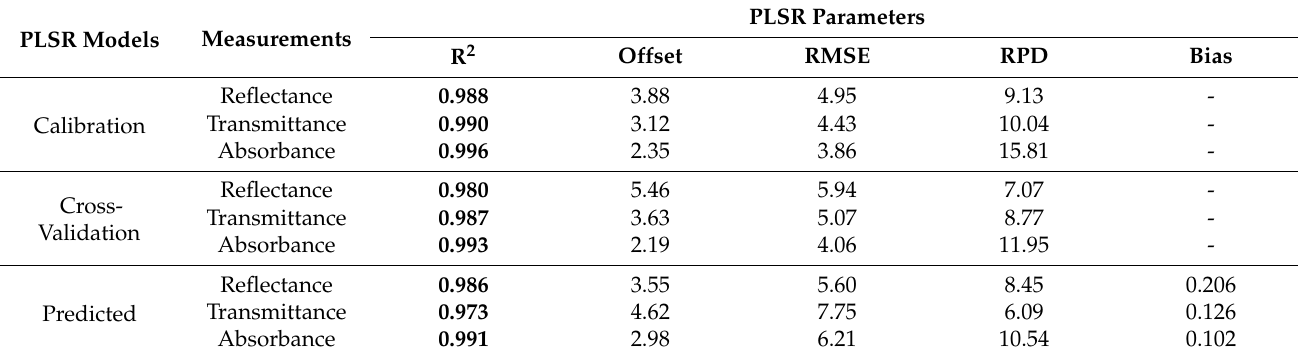
Table 3. PLSR model for thickness in calibration, cross-validation, and predicted reflectance, trans- mittance, and absorbance measurements. Model goodness-of-fit (R 2 ), offset, root mean square error (RMSE), ratio of performance to deviation (RPD), and bias parameters from hyperspectroscopy of green lettuce leaves. Bold indicates statistically significant regression (R 2